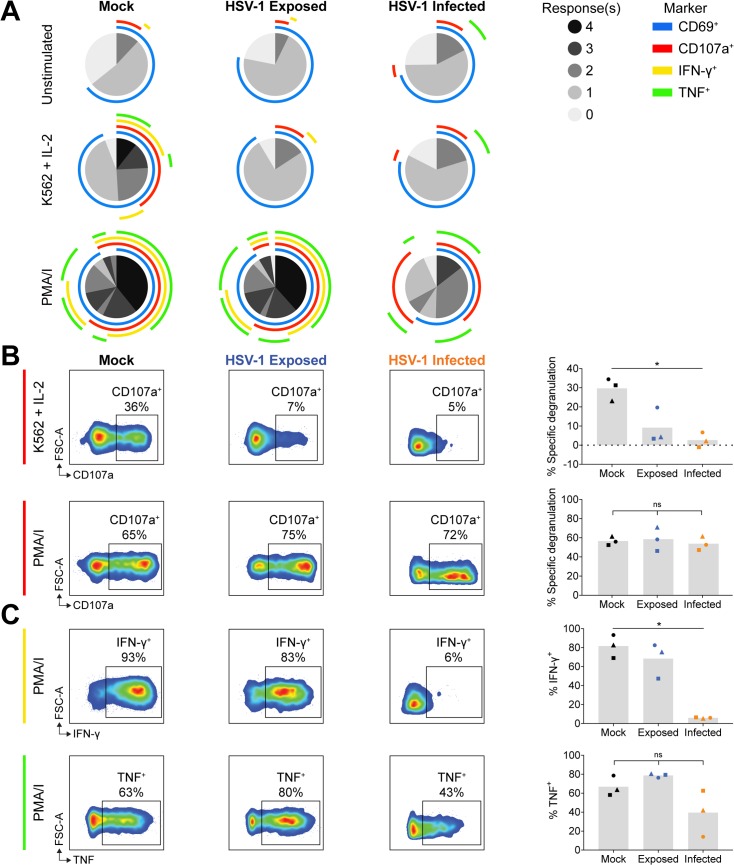
HSV-1 culture of NK cells reduces responsiveness to K562 stimulation and infection blocks IFN-γ expression.PBMCs were mock cultured, exposed to HSV-1, or HSV-1 infected for 1 day and stimulated as specified for flow cytometry analysis of NK cells (viable CD3–CD56+ cells). (A) SPICE pie charts show the proportion of responses to different stimuli (listed left) based on combinations of detected CD69, CD107a, IFN-γ and TNF expression. Arcs detail which markers were detected for each response (key right). Data represent the means of three donors. (B) Degranulation (CD107a+) following stimulation with K562 cells with IL-2 (top panel) or PMA/I (bottom panel). Graphs show specific degranulation for specified stimulus for three donors. (C) IFN-γ and TNF expression following stimulation with PMA/I. Graphs show frequencies of positive cells for three donors. Symbols represent individual donors, and grey columns indicate mean. *P < 0.05, ns = not significant (Friedman test with Dunn’s correction).